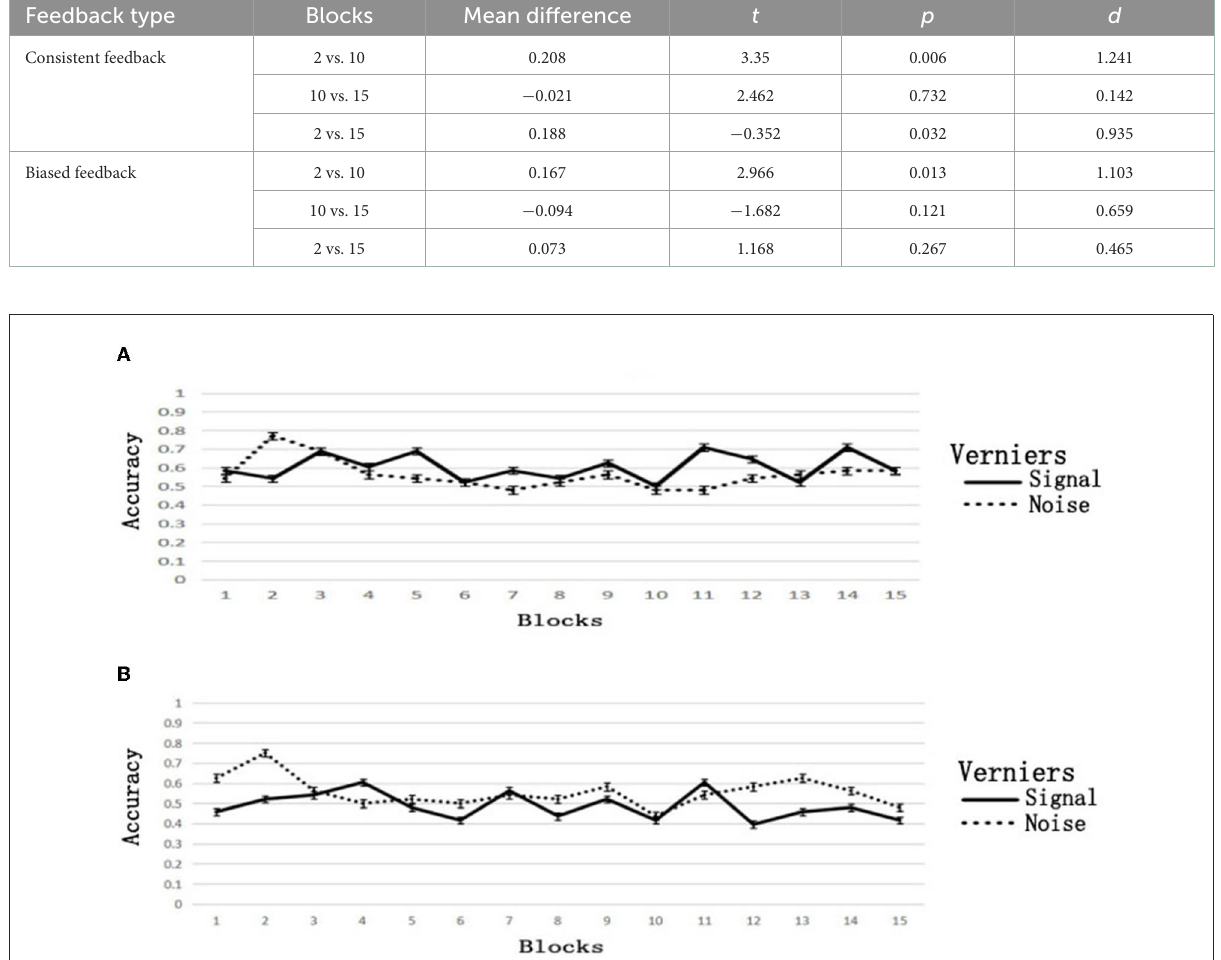
FIGURE4 Accuracy of block feedback without guidance. (A) Biased feedback, (B) consistent